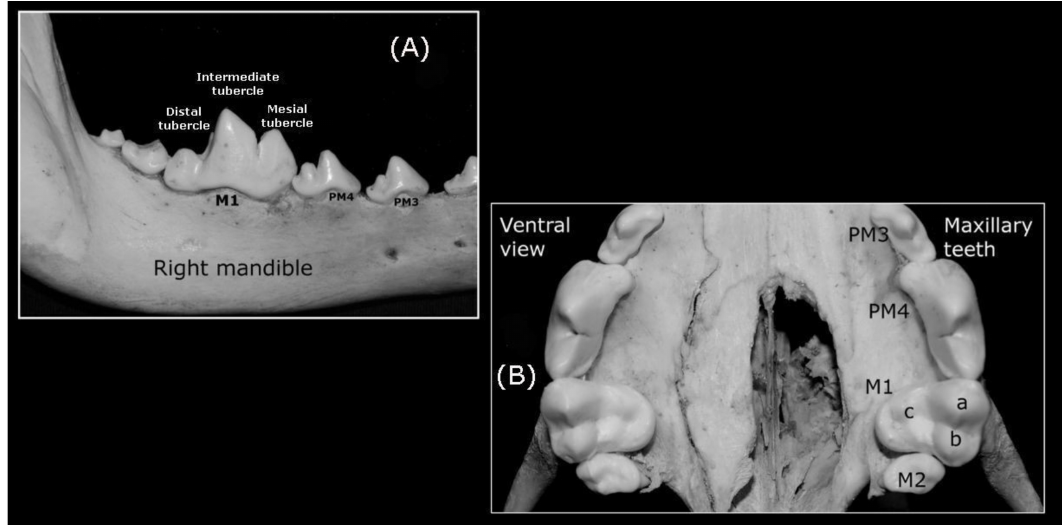
Figure 4. (A) Wolf‘s right mandible (lateral view) up to the PM4 tubercles and cusps; ( B ) The occlusive face of left maxillary M1 with its (a) mesiobuccal, (b) distobuccal and (c) distolingual tubercles and